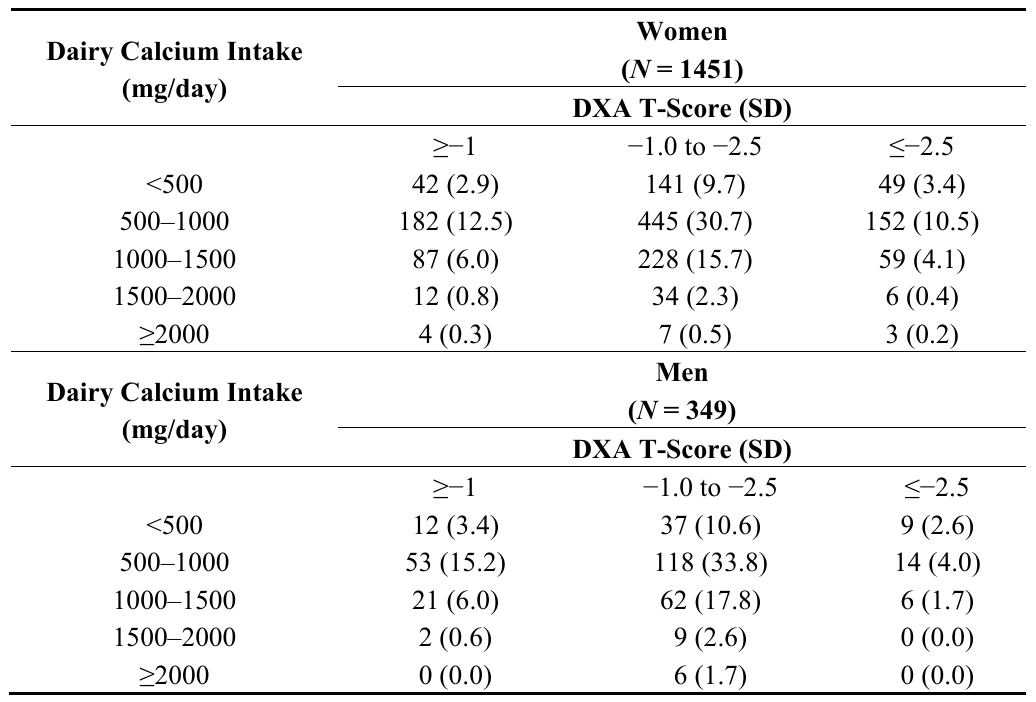
Table 6. Stratified Calcium intakes from dairy products in women and men grouped by Dual Energy X-Ray Absorptiometry (DXA)